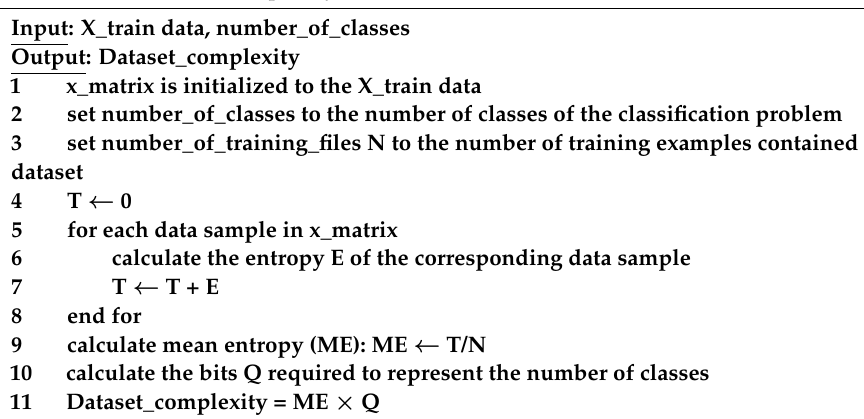
Algorithm 1 Dataset Complexity Estimation